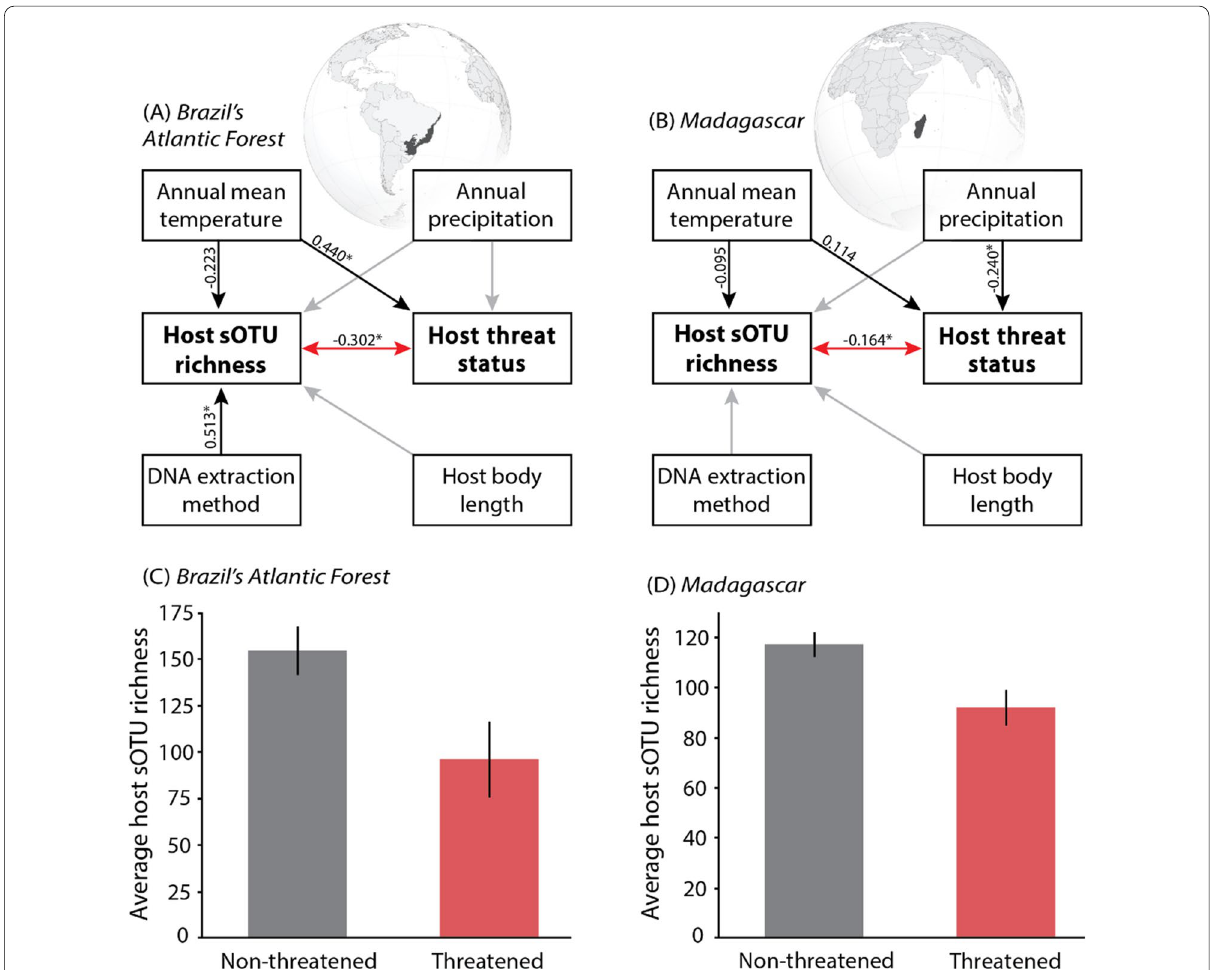
Fig. 1 Association between skin bacterial diversity and threat status of amphibian species in two geographically distinct biodiversity hotspots. A , B Piecewise structural equation models accounting for environmental, host, and methodological factors. Amphibian skin bacterial diversity was estimated as number of detected sub‑operational taxonomic units (sOTUs). Numbers are standardized coefficients (* p < 0.05). Unsupported paths shown as gray arrows were removed to improve model fit. Red arrows indicate the correlation of interest between host skin bacterial diversity and host threat status. Black arrows indicate other paths that were retained in the final pruned models. C , D Average skin sOTU richness between threatened (red) and non‑threatened (gray) species. Threatened species carried lower skin sOTU richness in ( C ) Brazil’s Atlantic Forest (t df 15.436, p 0.029) and D Madagascar (t 2.894, df 131.981, p 0.004). Error bars represent standard = = = − = =